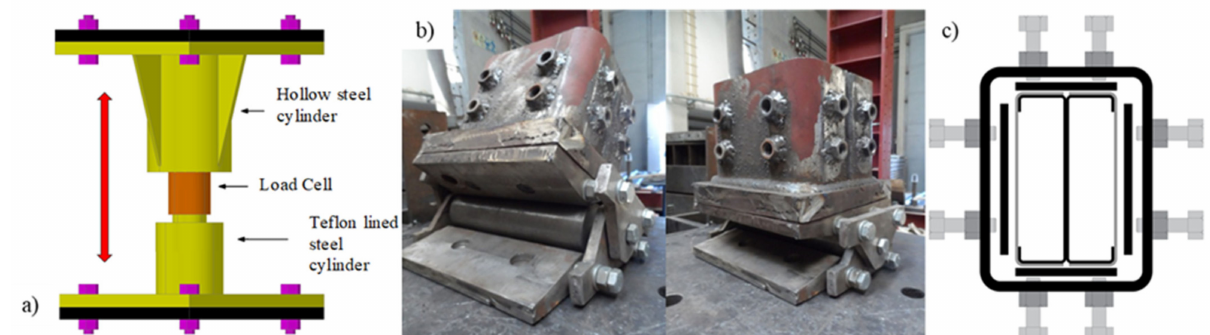
Figure 2. Schematic view of the experimental test set-up. ( a ) 3D view with the furnace open. ( b ) Furnace closed.